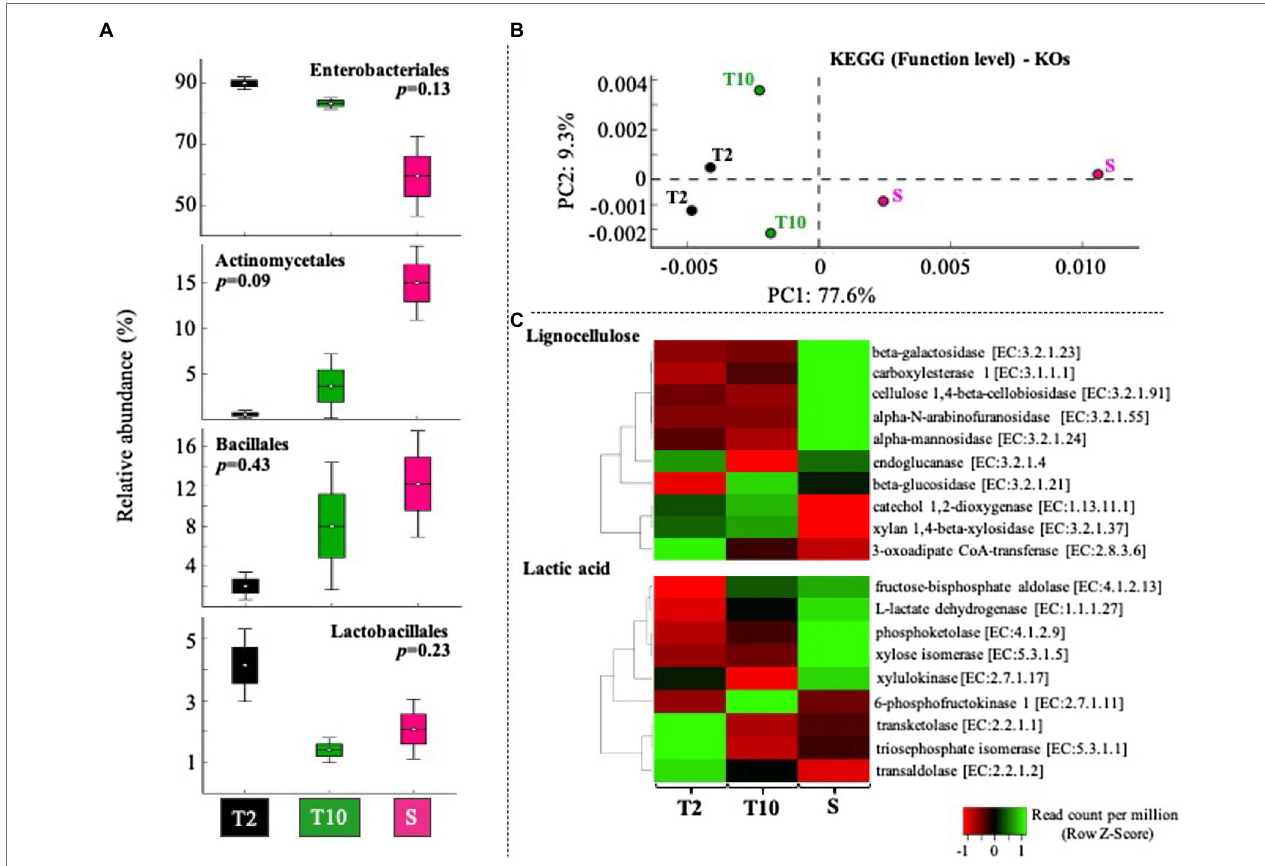
FIGURE 4 | Gene-centric metagenomic analysis of selected consortia after transfer T2, T10, and the scale-up growth process (S). (A) Relative proportion (%) of the most abundant orders ( Enterobacteriales > Actinomycetales > Bacillales > Lactobacillales ). Sequences taxonomic assignment was carried out by using RefSeq database. (B) Clustering based on functional assignment (KEGG databases) of annotated sequences at KOs level. (C) Heat map of normalized abundance values (Row Z score) obtained using the number of sequences annotated within 10 enzyme-encoding genes involved in lignocellulose degradation and nine enzyme- encoding genes involved in heterolactic and/or homolactic fermentation of